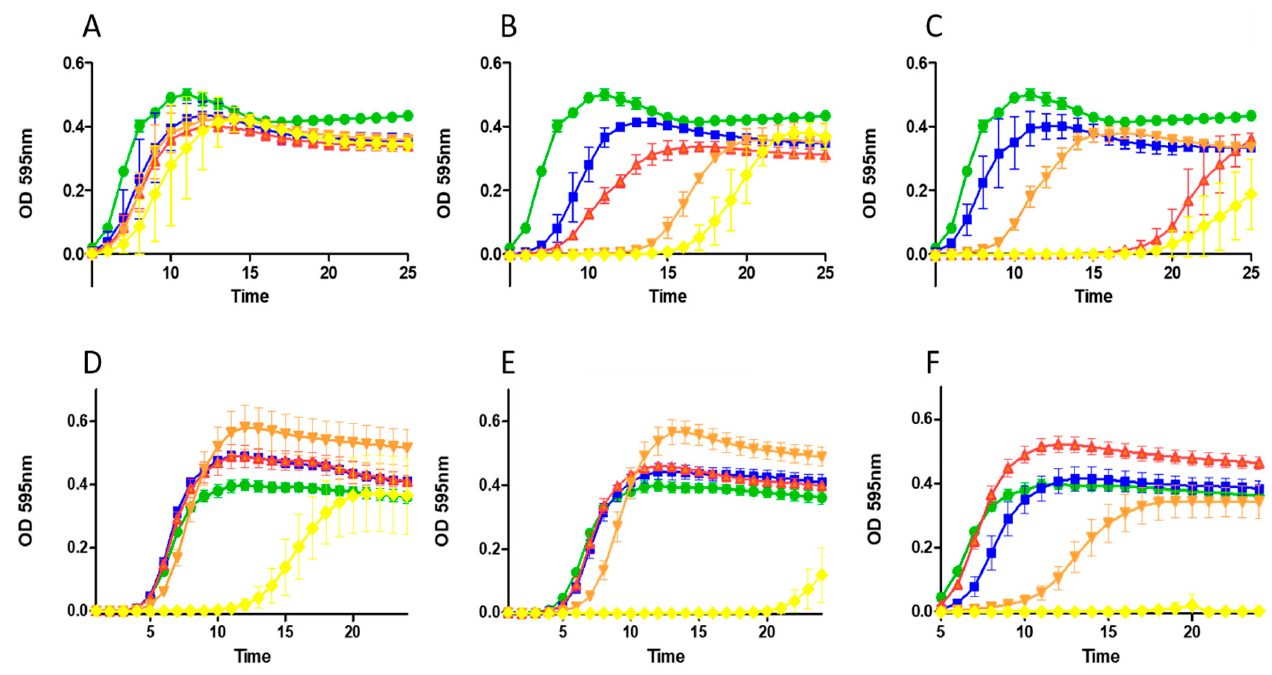
Figure 2. Impact of increasing concentrations of nisin A and nisin derivatives on growth of staphylococci. Effect of nisin A (blue square) and nisin variants nisin A M17Q (orange triangle), nisin A HTK (red triangle) and nisin A T2L (yellow diamond) and untreated control (green circle) on S. aureus RF122 in 0.32 µ g mL − 1 ( A ), 0.48 µ g mL − 1 ( B ) and 0.64 µ g mL − 1 ( C ) and S. aureus SA113 in 3.2 µ g mL − 1 ( D ), 4.8 µ g mL − 1 ( E ) and 6.4 µ g mL − 1 ( F ), The means and standard deviations of three independent determinations are presented.